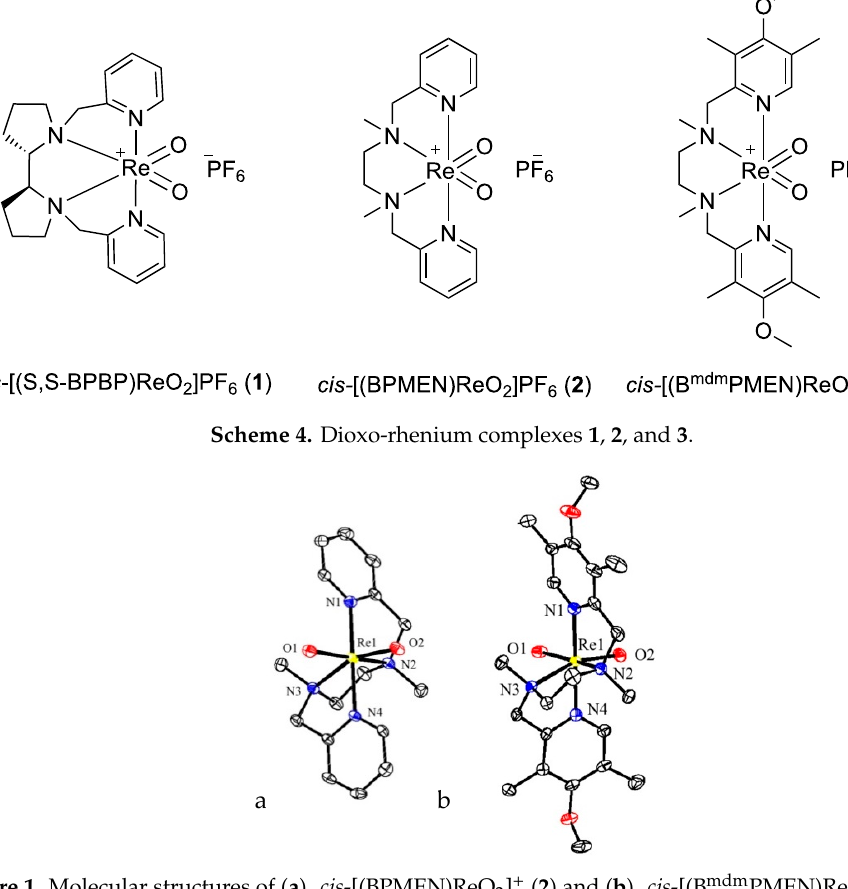
Table 1. Selected bond distances (Å) and angles (°) of cis -dioxo-rhenium complexes, cis -[(S,S-